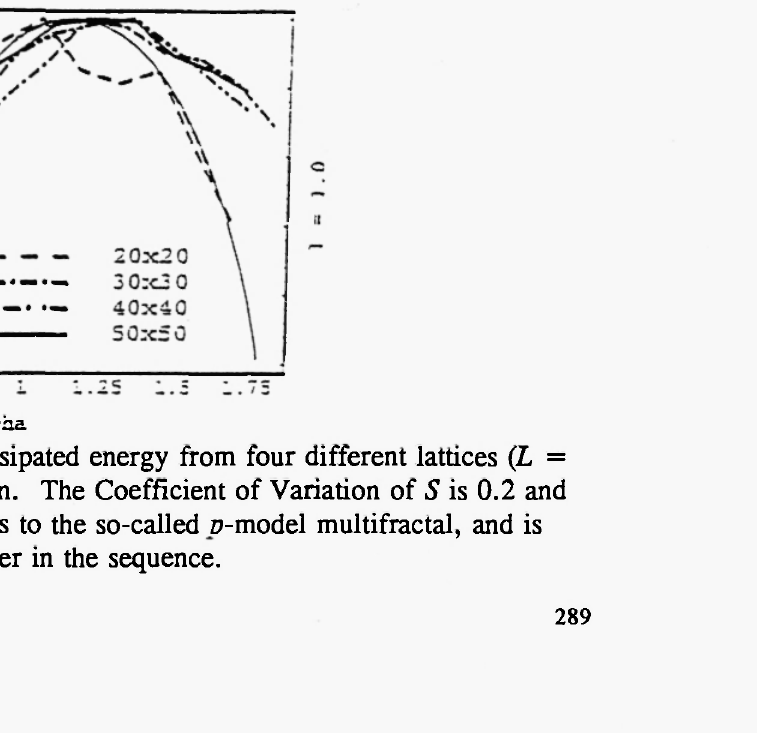
Figure 1: Rescaled log-histogram of the dissipated energy from four different lattices (L = 20, 30, 40, 50) subjected to uniaxial tension. The Coefficient of Variation of S is 0.2 and IJL = 1. The thin solid line corresponds to the so-called model multifractal, and is discussed further in the